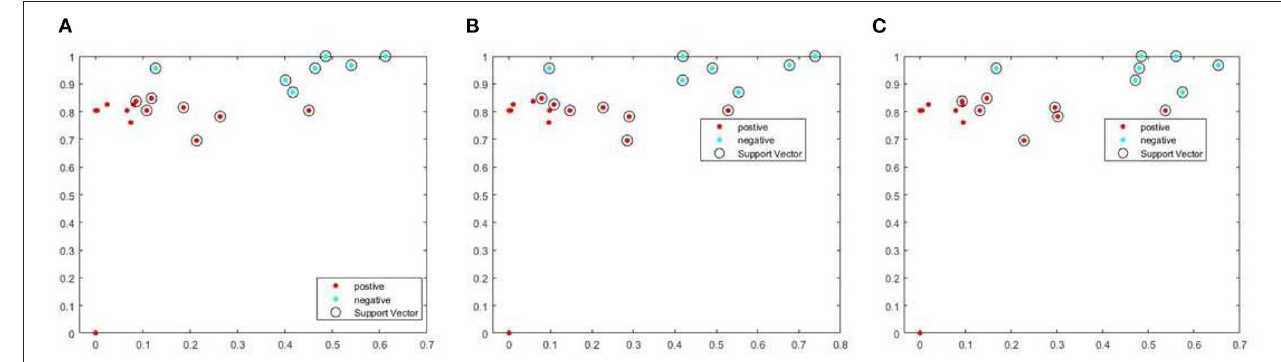
FIGURE 3 | The impact of different weights on AI precision education. (A) 0.18:0.4:0.42, (B) 0.19:0.13:0.68, and (C)